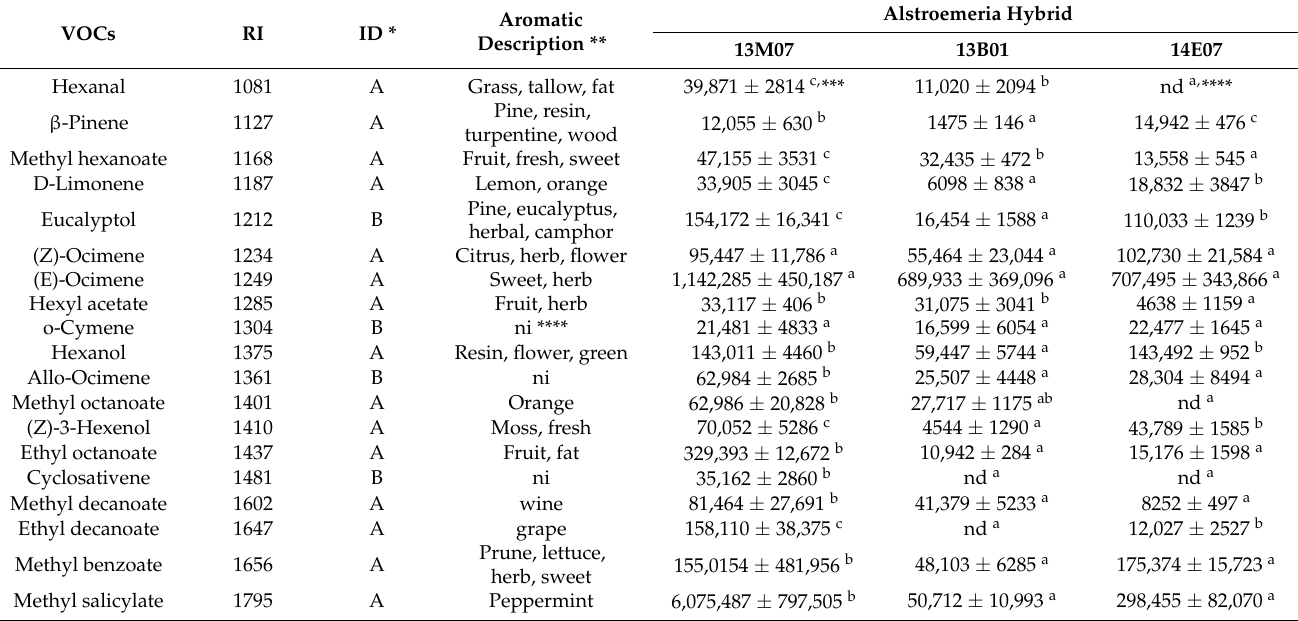
Table 2. Floral scent composition of scented (13M07 and 14E07) and non-scented (13B01) alstroemeria hybrids, showing the Retention Index (RI), system of identification (ID), aromatic description and amount (peak area expressed in arbitrary